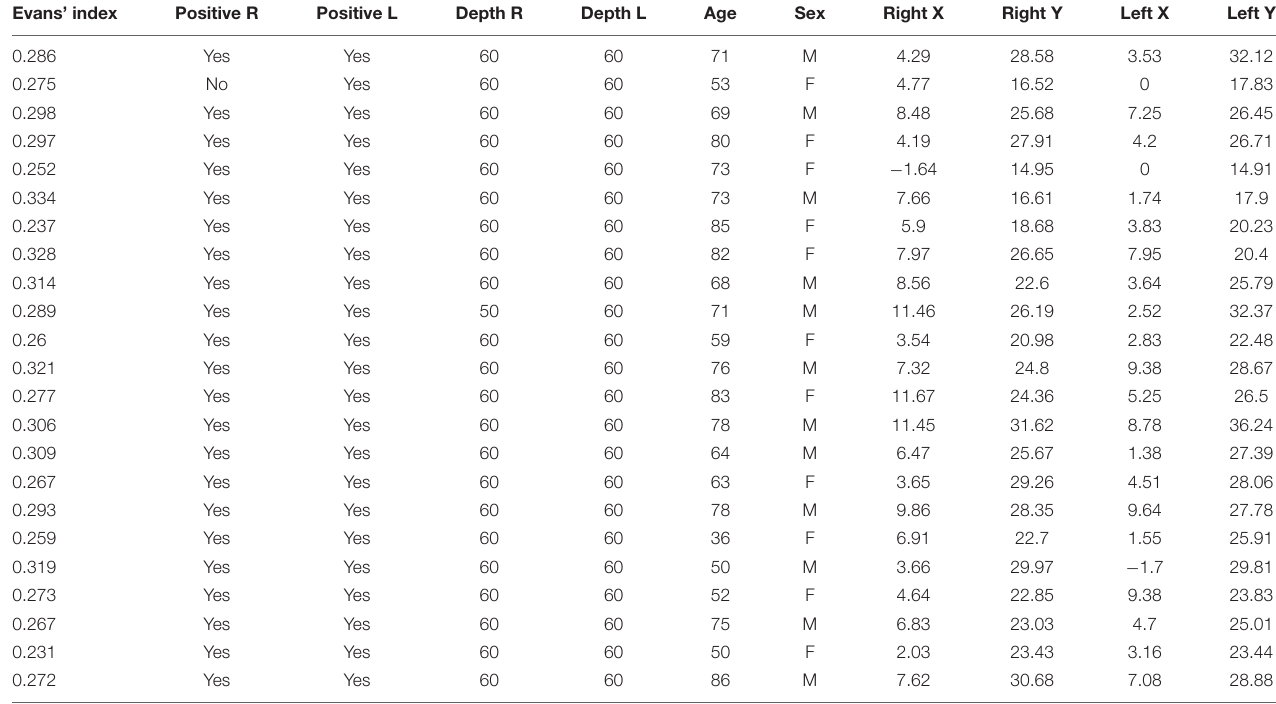
TABLE 2 | Computer-based simulation with report of Evans’ index, depth in both sides, and data analysis. Evans’ index